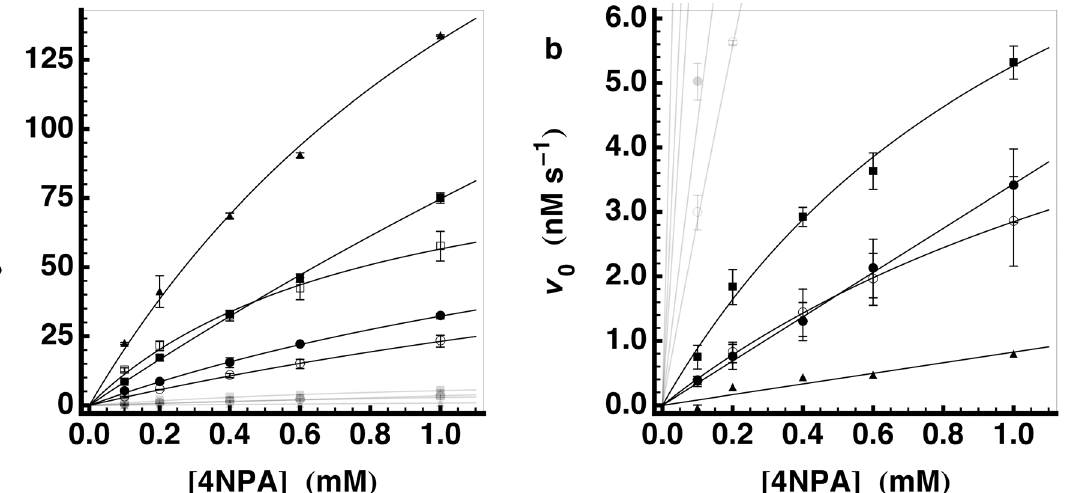
Fig 2. Esterase activity of selected peptides at pH 7.3. Esterase activity for a selection of peptides is shown. Plots show the initial hydrolysis rate of 4NPA as a function of initial substrate concentration together with the fit of the data to the Michaelis-Menten equation. The symbols for the individual peptides are in Table 3. In (a) all of the peptides that were measured are shown (the less active peptides greyed out), while in (b) the same data is plotted on a smaller scale to show the less active peptide